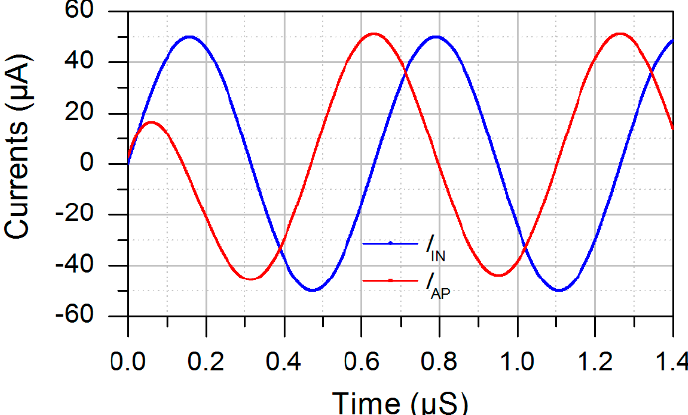
Figure 5. Differential input current and differential AP output current at 1.58 MHz.